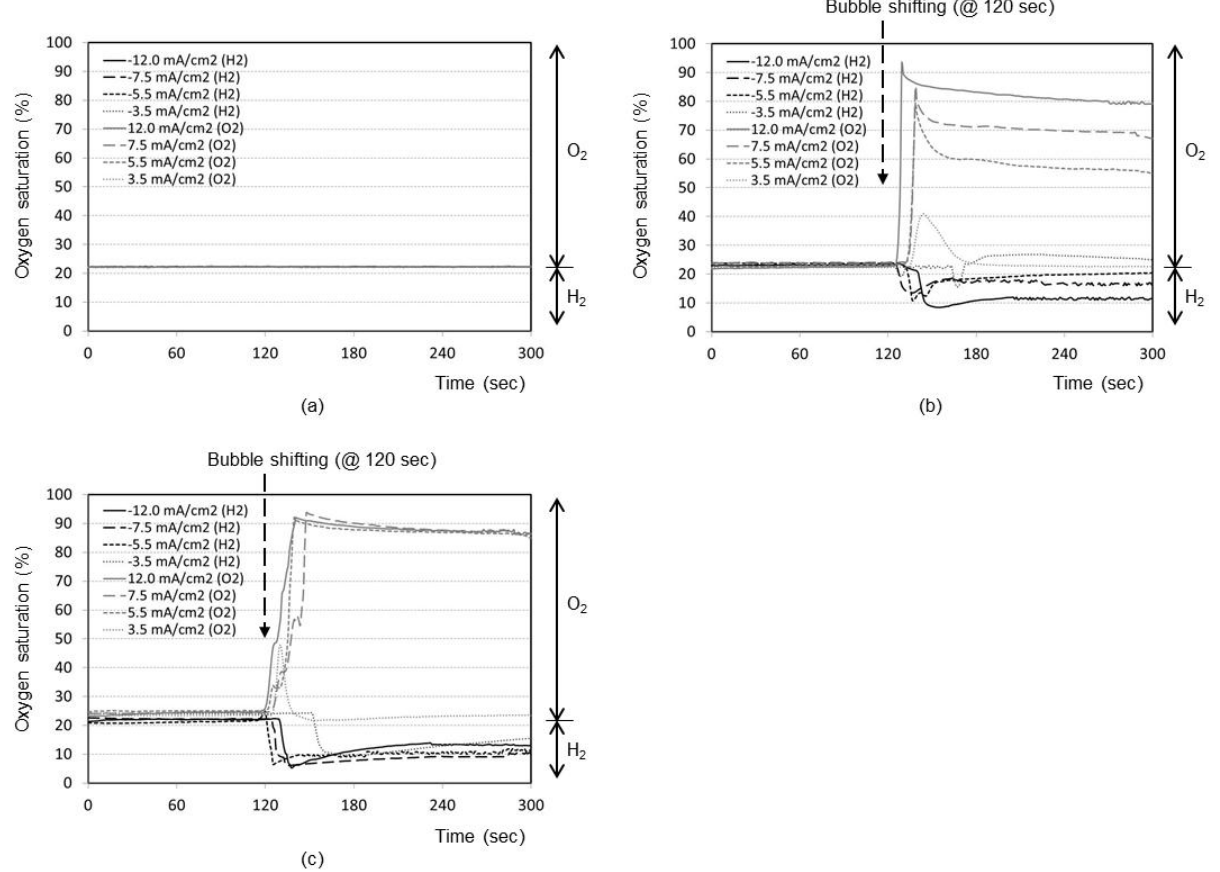
Figure 3. Responses of oxygen sensor during bubble generation (2 min) and shifting towards bubble stopper. Sample oxygen at the sensor location decreases when the hydrogen bubble arrives, while it increases when the oxygen bubble arrives, respectively. ( a )